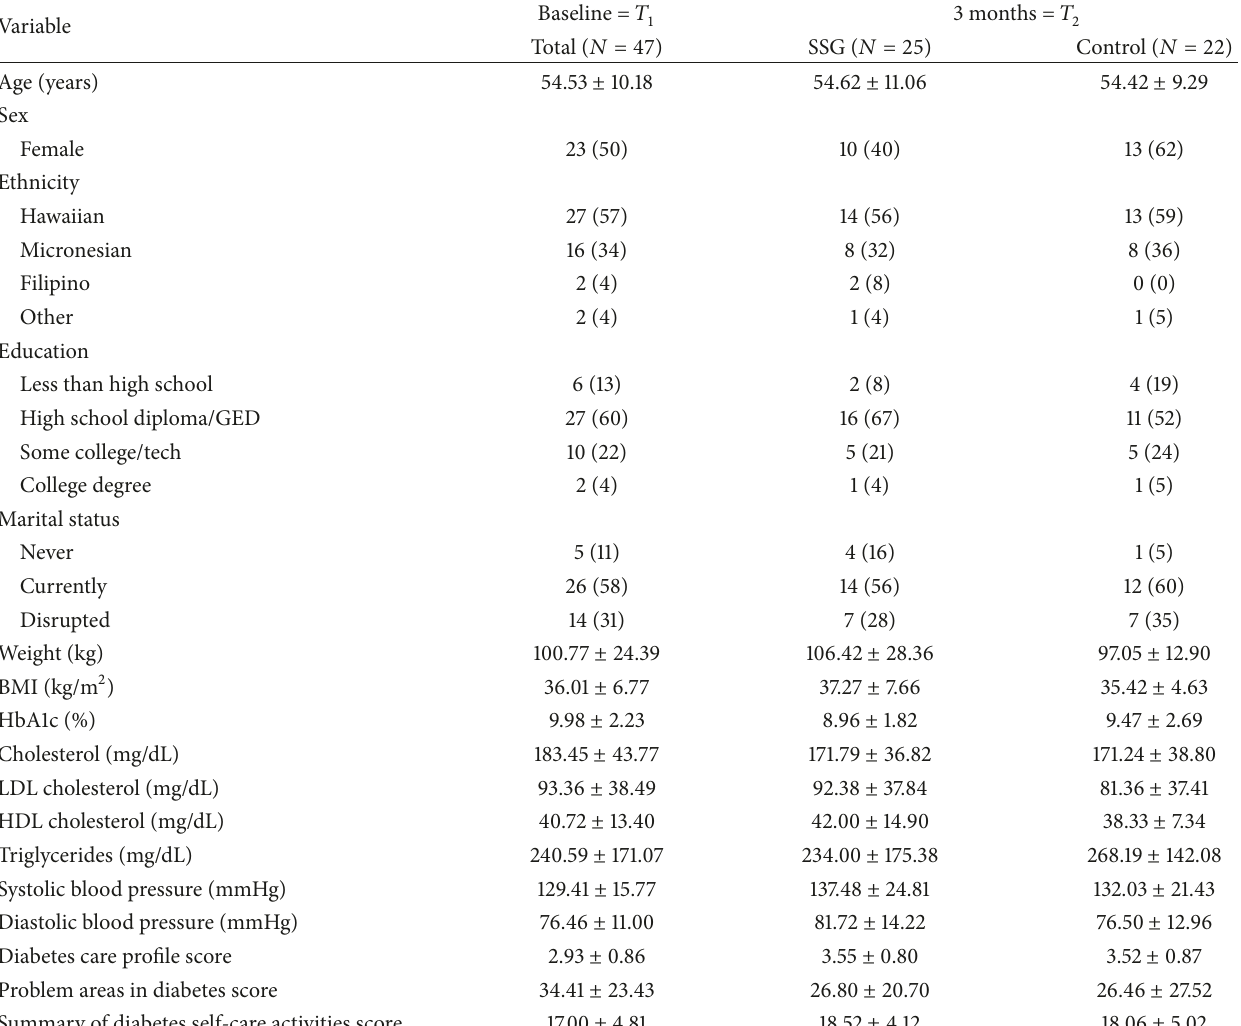
Table 1: Participants’ sociodemographic, behavioral, and biological characteristics for combined sample at 𝑇 1 and by group at 𝑇 2